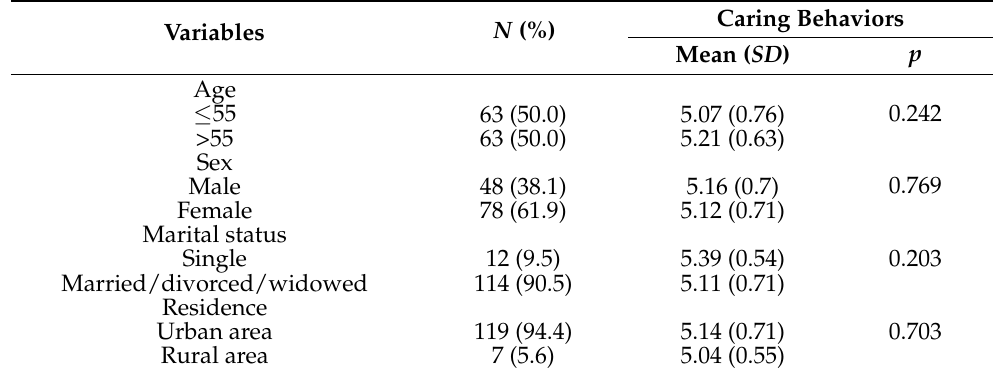
Table 2. Association between general information variables and patients’ self-evaluated caring behaviors ( n =